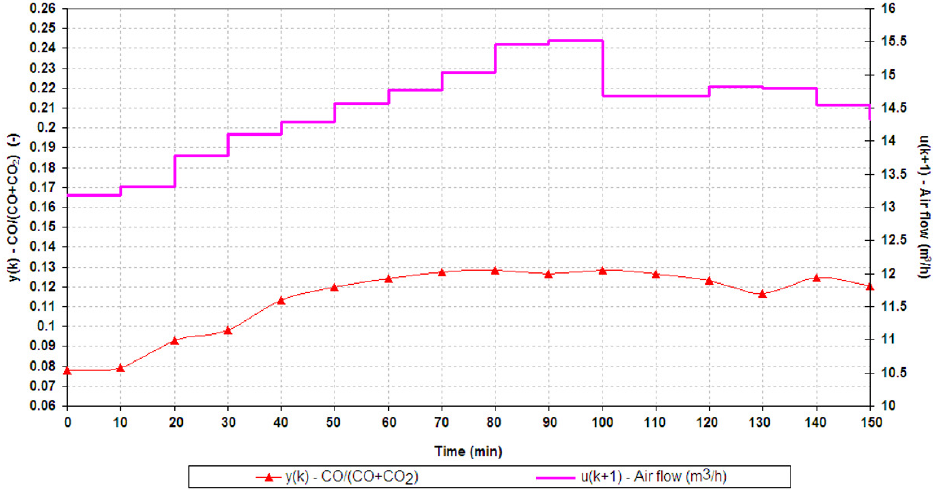
Figure 12. Maximization of the ratio of CO/(CO + CO 2 ) with extremal controller